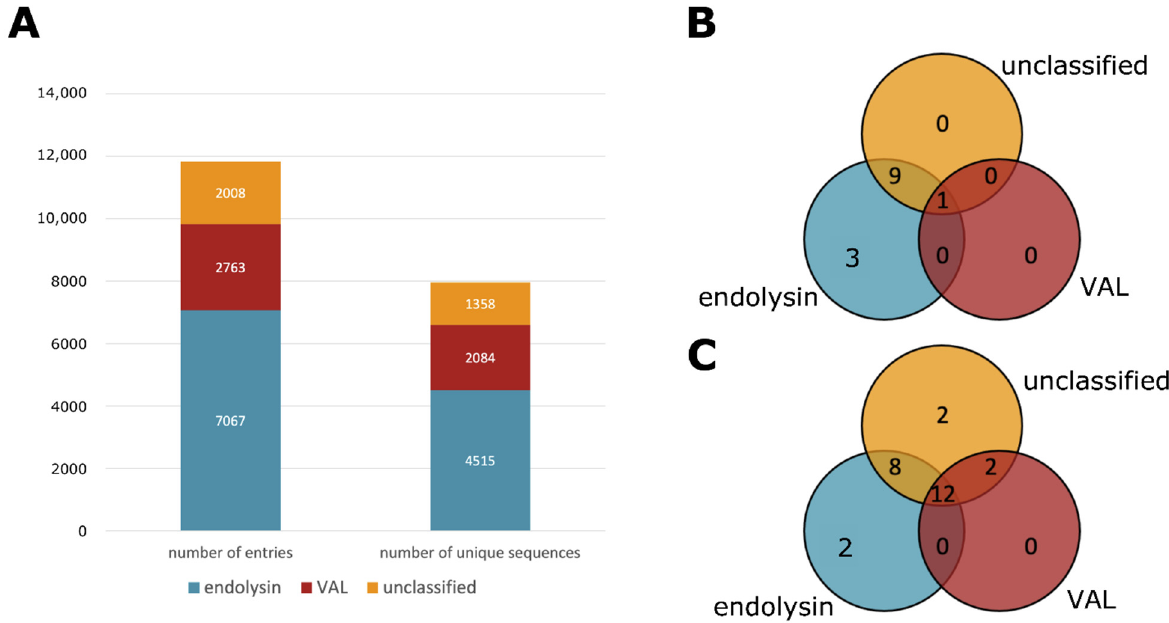
Figure 3. Overview of the types of proteins in PhaLP and the domain clusters observed in them. ( A ) A bar plot of the total number of entries and unique amino acid sequences divided into endolysins and VALs; ( B ) a Venn diagram of the number of CBDs unique to each protein type; ( C ) a Venn diagram of the number of EADs unique to each protein type. The third group (unclassified) denotes proteins that were not classified as either endolysin or VAL with a certainty of at least